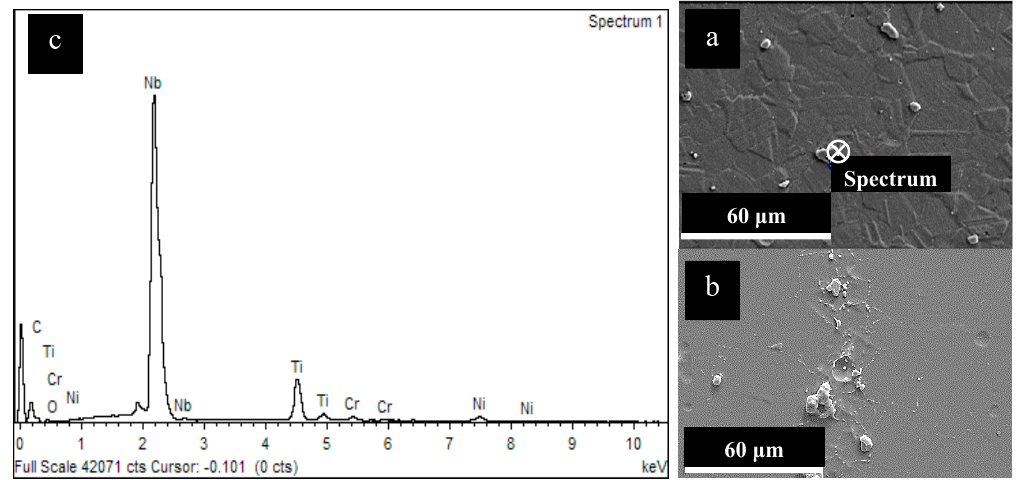
Figure 4. Microstructure of HW specimens ( a , b ) (Kalling’s attack) and EDS spectrum of macro-precipitates ( c ) taken in the point evidenced in ( a ).